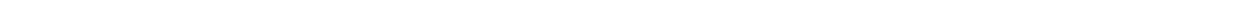
Fig. 4 Patient classi fi cation and biological interpretation of the patient clusters. a The correlation matrix of the hallmark gene sets was clustered into four global factors with biological characteristics. Each bar indicates the loading strength of a hallmark gene set in each factor. Blue (red) bars represent positive (negative) values, and absolute values were used for the negative values. b The four clusters were classi fi ed with statistical clustering ( k -means) analysis of the factor scores of the patients. The hypergeometric test was performed to examine the statistical signi fi cance of the enrichment of individual CMS groups in each cluster. c Biological interpretation of the clusters with the identi fi ed Factors, each of which corresponds to a biological signature of a CMS group. The distribution of the Factor scores of the patients in one cluster was compared to that of the other remaining clusters. p -values were obtained by performing the Wilcoxon rank-sum test. d Distribution of the tumor stages in each cluster. Red asterisks indicate statistical signi fi cance (hypergeometric test, p < 0.05). e Comparison of average values of − log ( p -value) of each cluster in individual signi fi cant hallmark gene sets. f Comparison of the statistical signi fi cance ( − log ( p -value)) of three clusters in each signi fi cant hallmark gene set. Red asterisks indicate that there are signi fi cant differences in the statistical test results between a group with the highest value and the other two groups (Wilcoxon rank-sum test, p < 0.05). Error bars indicate the standard error. g Summary of the relationships between the hallmark gene sets and the tumor stages in the individual